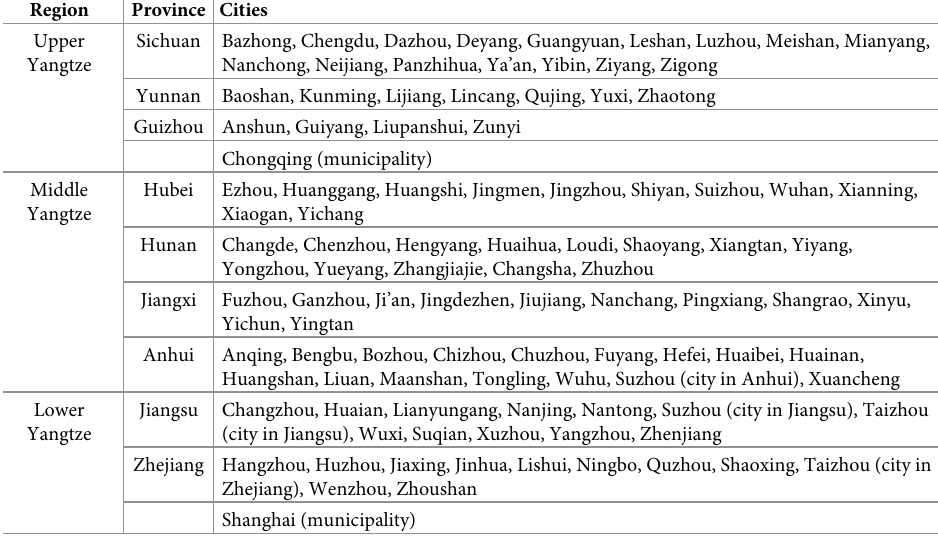
Table 6. Samples selected from 2004 to